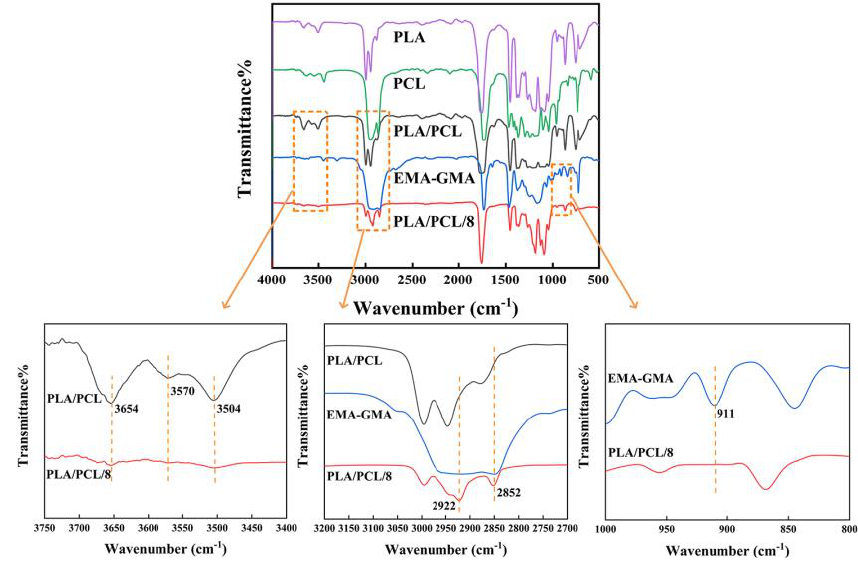
/ PCL and PLA / PCL / 8